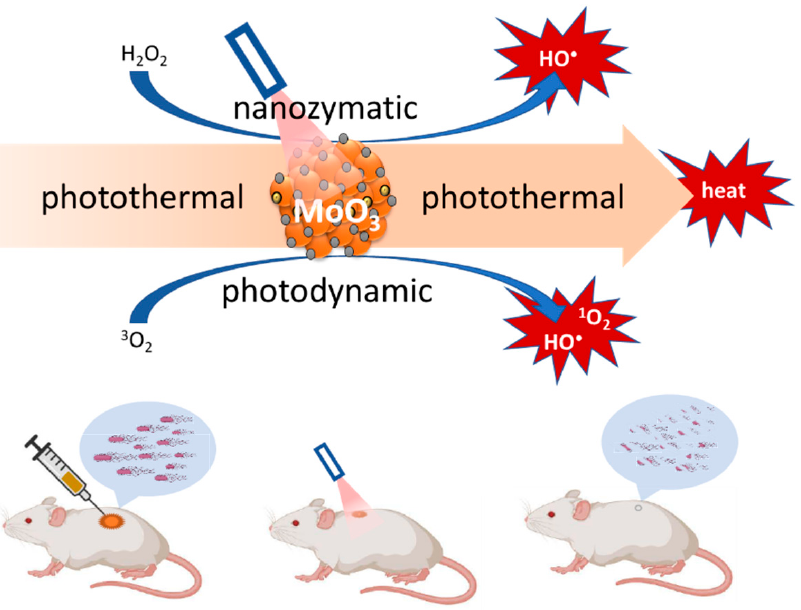
Figure 2. Illustration of the triple therapy combination of PTT, PDT, and nanozyme effect of molybdenum trioxide nanoparticles.